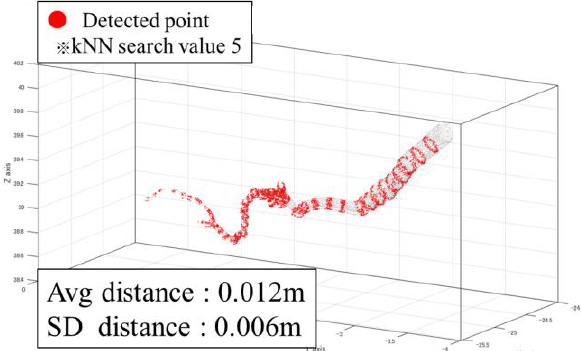
Figure 12. Part of branches accuracy